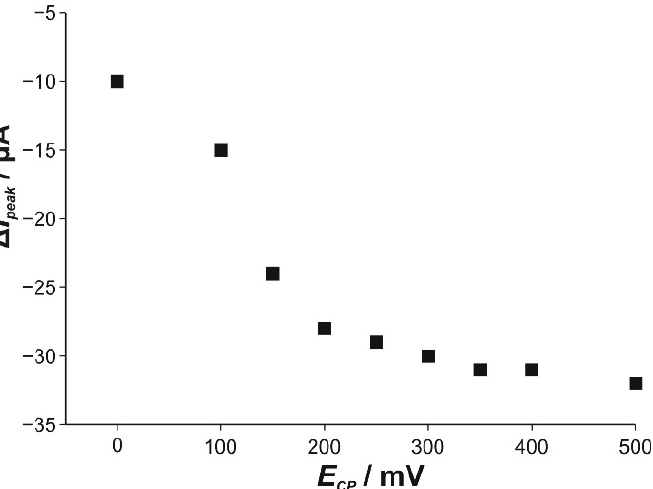
Figure 7. The effect of the conditional potentials on the DPV signal. DPVs were recorded with CPE modified with 5% of material in the presence of 17 μ M of cysteine at pH 5. Other measurement parameters: conditional time 20 s, pulse amplitude 0.05 V, pulse width 0.05 s, step potential 0.01 V.